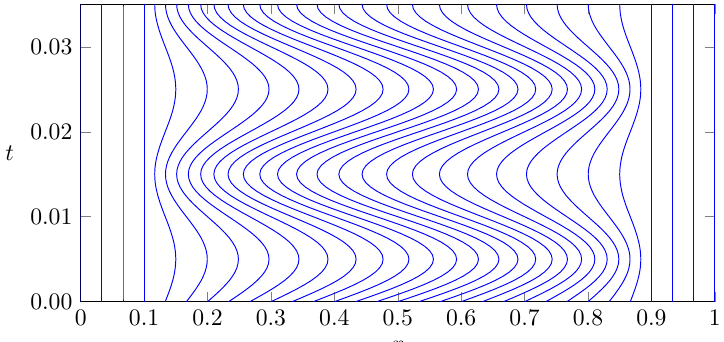
Figure 3. Time evolution of an equidistant initial grid under the grid motion given in Equations (80) and (81) until time T =